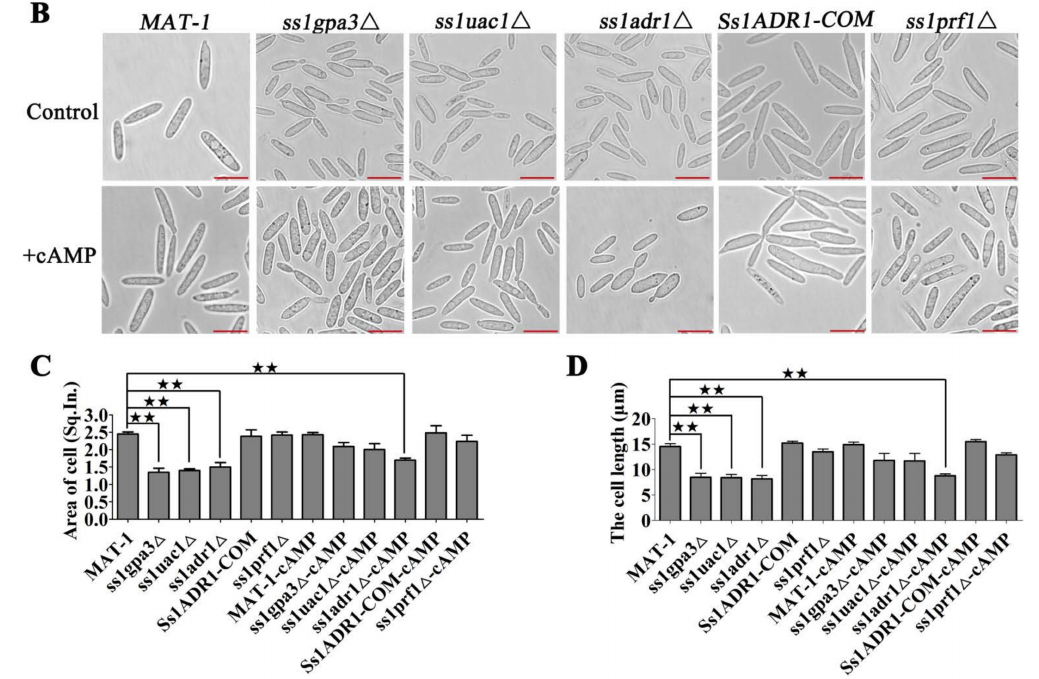
Figure 1. Effects of cAMP/PKA signaling pathways on morphology of S. scitamineum. ( A ) The colony morphology of MAT-1 , ss1gpa3 ∆ , ss1uac1 ∆ , ss1adr1 ∆ , Ss1ADR1-COM , and ss1prf1 ∆ strains. MAT-1 , ss1gpa3 ∆ , ss1uac1 ∆ , ss1adr1 ∆ , Ss1ADR1-COM , and ss1prf1 ∆ haploid sporidia were cultured under YePSA medium with or without exogenetic cAMP (5 mM). Images were taken 4 days after cultivation. Scale bar = 5.0 mm. ( B ) The microscopic morphology of wild-type MAT-1 , ss1gpa3 ∆ , ss1uac1 ∆ , ss1adr1 ∆ , Ss1ADR1-COM , and ss1prf1 ∆ strains. MAT-1 , ss1gpa3 ∆ , ss1uac1 ∆ , ss1adr1 ∆ , Ss1ADR1-COM , and ss1prf1 ∆ haploid sporidia were allowed to grow till O.D. 600 = 1.0, and treated with or without exogenetic cAMP (5 mM) under YePSA medium at 28 ◦ C for 24 h. Images were taken by Leica DMI8 Inverted Fluorescence Microscope. Scale bar = 10 µ m. ( C ) The cell areas of MAT-1 , ss1gpa3 ∆ , ss1uac1 ∆ , ss1adr1 ∆ , Ss1ADR1-COM , and ss1prf1 ∆ strains were measured. MAT-1 , ss1gpa3 ∆ , ss1uac1 ∆ , ss1adr1 ∆ , Ss1ADR1-COM , and ss1prf1 ∆ haploid sporidia were allowed to grow till O.D. 600 = 1.0 with or without exogenetic cAMP (5 mM), and then images were taken by Leica DMI8 Inverted Fluorescence Microscope. Adobe Photoshop software was used to calculate the pixels of each cell. One square inch (Sq. In.) is 72 by 72 pixels. Bar chart depicts statistical difference between (cid:70)(cid:70) p the mean values ( < 0.01). The sample was independently performed with three independent biological repeats, each of which contained twenty replications. ( D ) The cell lengths of MAT-1 , ss1gpa3 ∆ , ss1uac1 ∆ , ss1adr1 ∆ , Ss1ADR1-COM , and ss1prf1 ∆ strains were measured. MAT-1 , ss1gpa3 ∆ , ss1uac1 ∆ , ss1adr1 ∆ , Ss1ADR1-COM , and ss1prf1 ∆ haploid sporidia were allowed to grow till O.D. 600 = 1.0 with or without exogenetic cAMP (5 mM), and then images were taken by Leica DMI8 Inverted Fluorescence Microscope and the length of the cell was measured. The unit is µ m. Bar chart (cid:70)(cid:70) p depicts statistical difference between the mean values ( < 0.01). The sample was independently performed with three independent biological repeats, each of which contained twenty